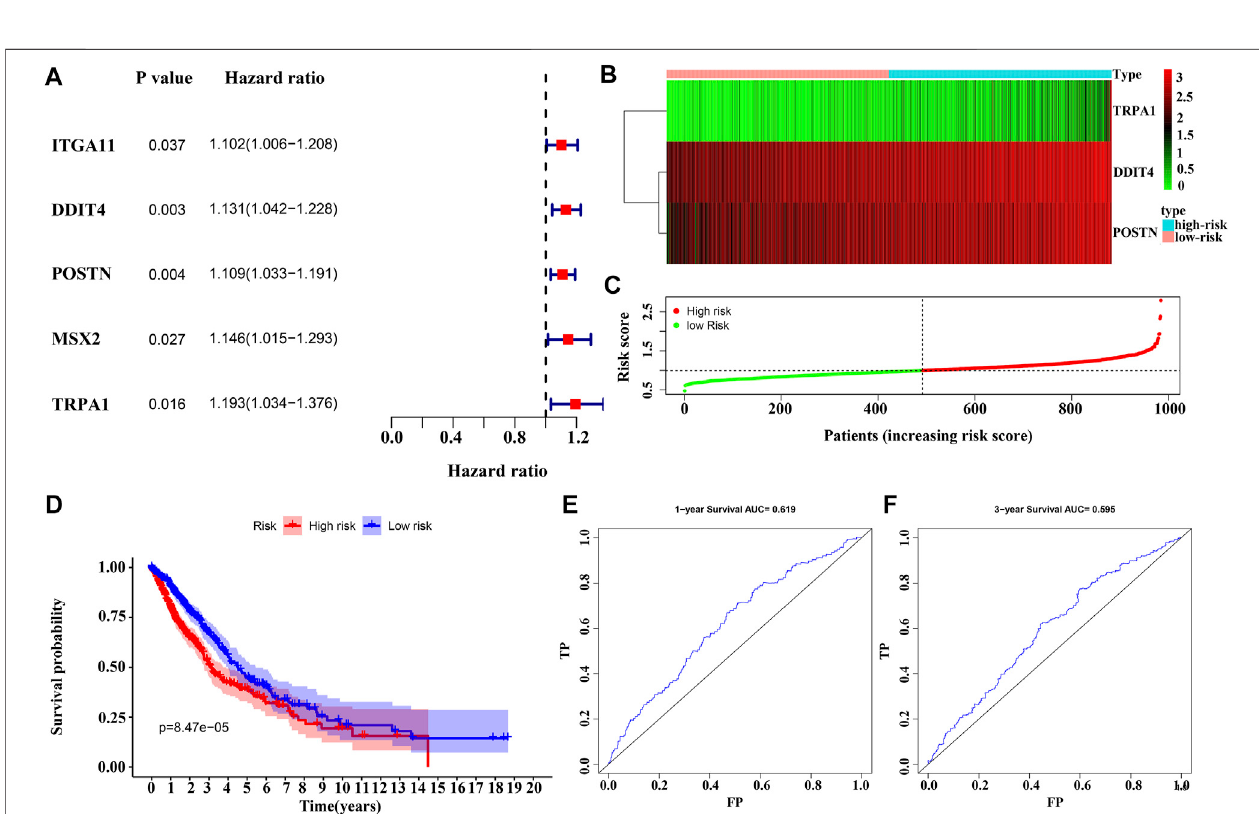
FIGURE5| ConstructionofMSCDEGsprognosticriskmodel. (A – B) PrognosticmodelfactorsofNSCLCpatientsusingCOXanalysis; (C – D) Riskscorecorrelates with the survival time of NSCLC patients; (E – F) The usefulness of risk model using the ROC analysis. NSCLC, non-small-cell lung cancer; ROC, receiver operating characteristic; MSCs, Mesenchymal stem cells; DEGs, differentially expressed genes.